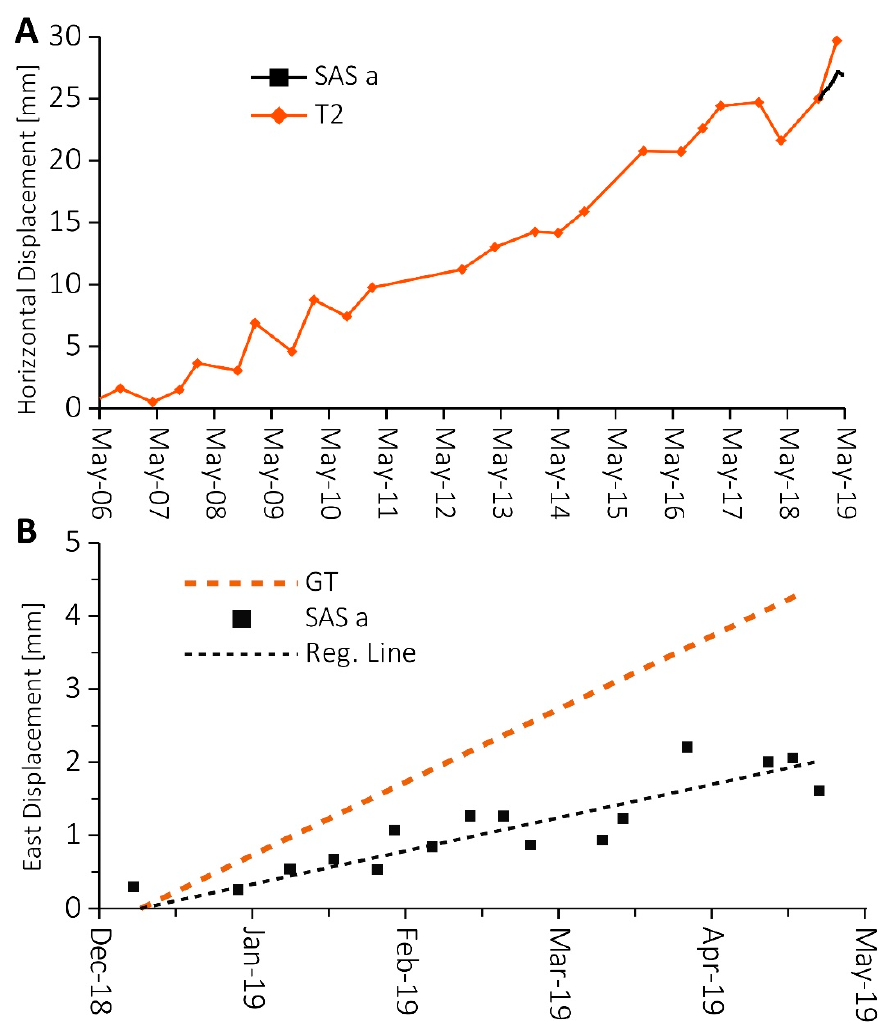
Figure 12. ( A ) shows a comparison of horizontal displacement between GNNS “SAS a” based on weekly averaged measurements from December 2018 to May 2019 and topographic “T2” for the period 2006–2019; ( B ) shows GNSS “SAS a” East displacement averaged with weekly sampling and its regression line (equation f (x) = 0.01x − 634.47; R 2 = 0.86) compared with geological thresholds (GT) of 3 mm/100 days (11 mm/year).